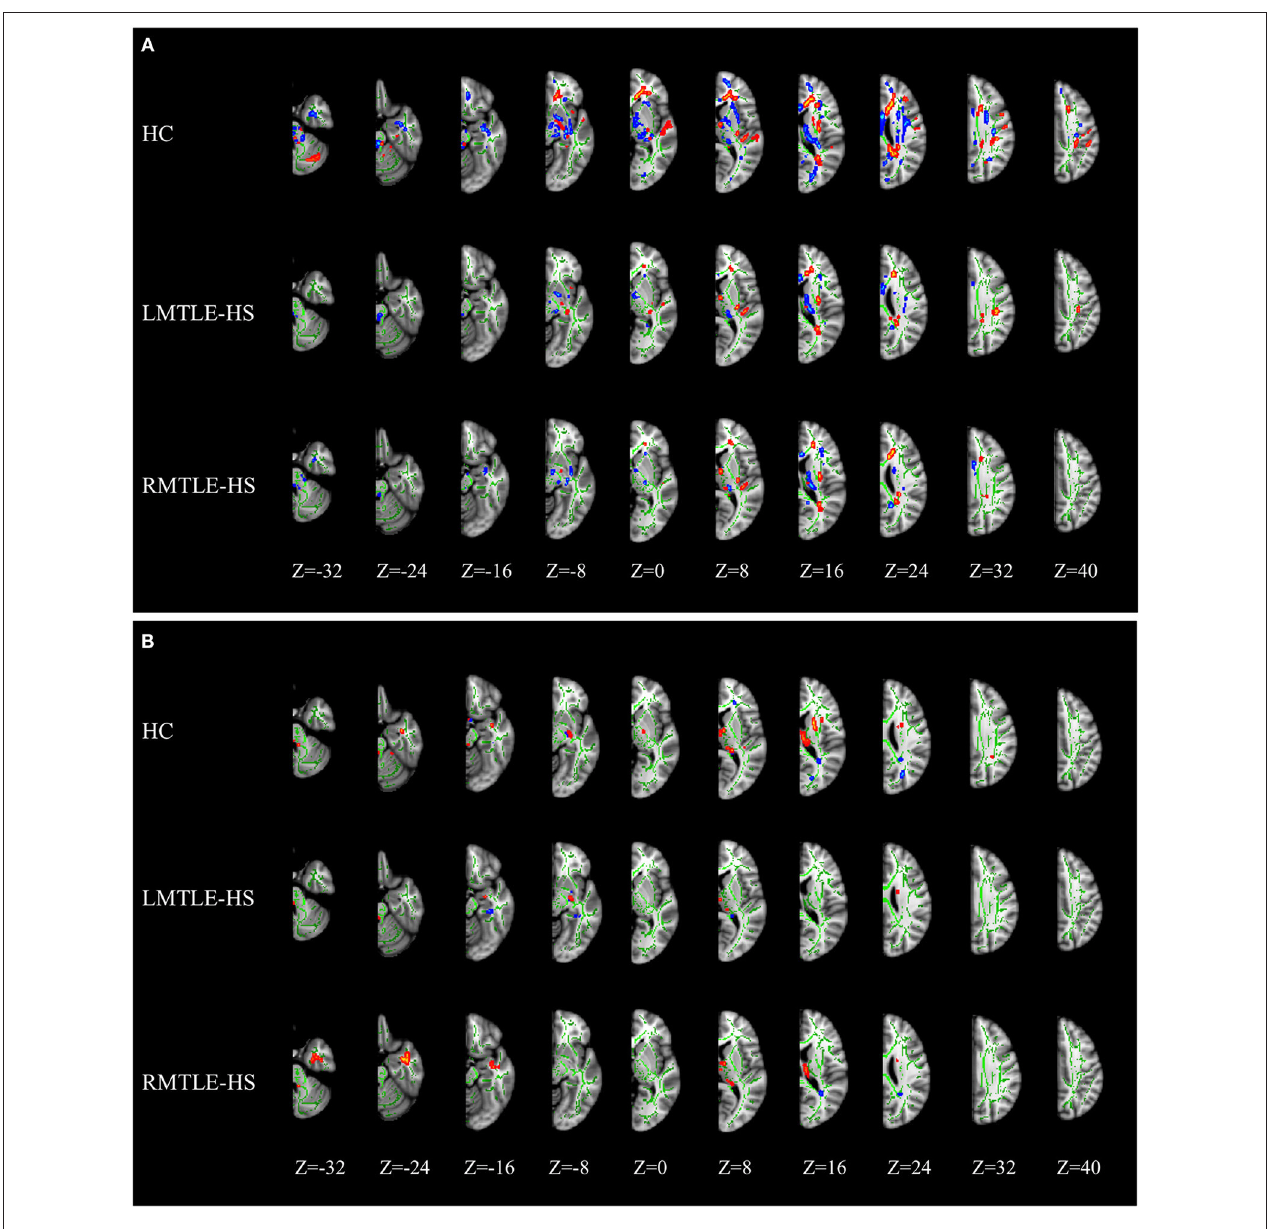
FIGURE 1 | MRI images of significant tract-based spatial statistics (TBSS) clusters of white matter asymmetry in healthy controls, patients with left mesial temporal lobe epilepsy with hippocampal sclerosis (LMTLE-HS) and patients with right MTLE-HS. (A) Represents fractional anisotropy (FA) and (B) represents mean diffusivity (MD). Results are presented on the left hemisphere of the symmetric TBSS skeleton (depicted in green). Rightward asymmetry that was defined as having a larger FA/MD value of the right brain (R) than the left (L) (R > L) depicted in blue-light-blue and leftward asymmetry (L > R) in red-yellow.